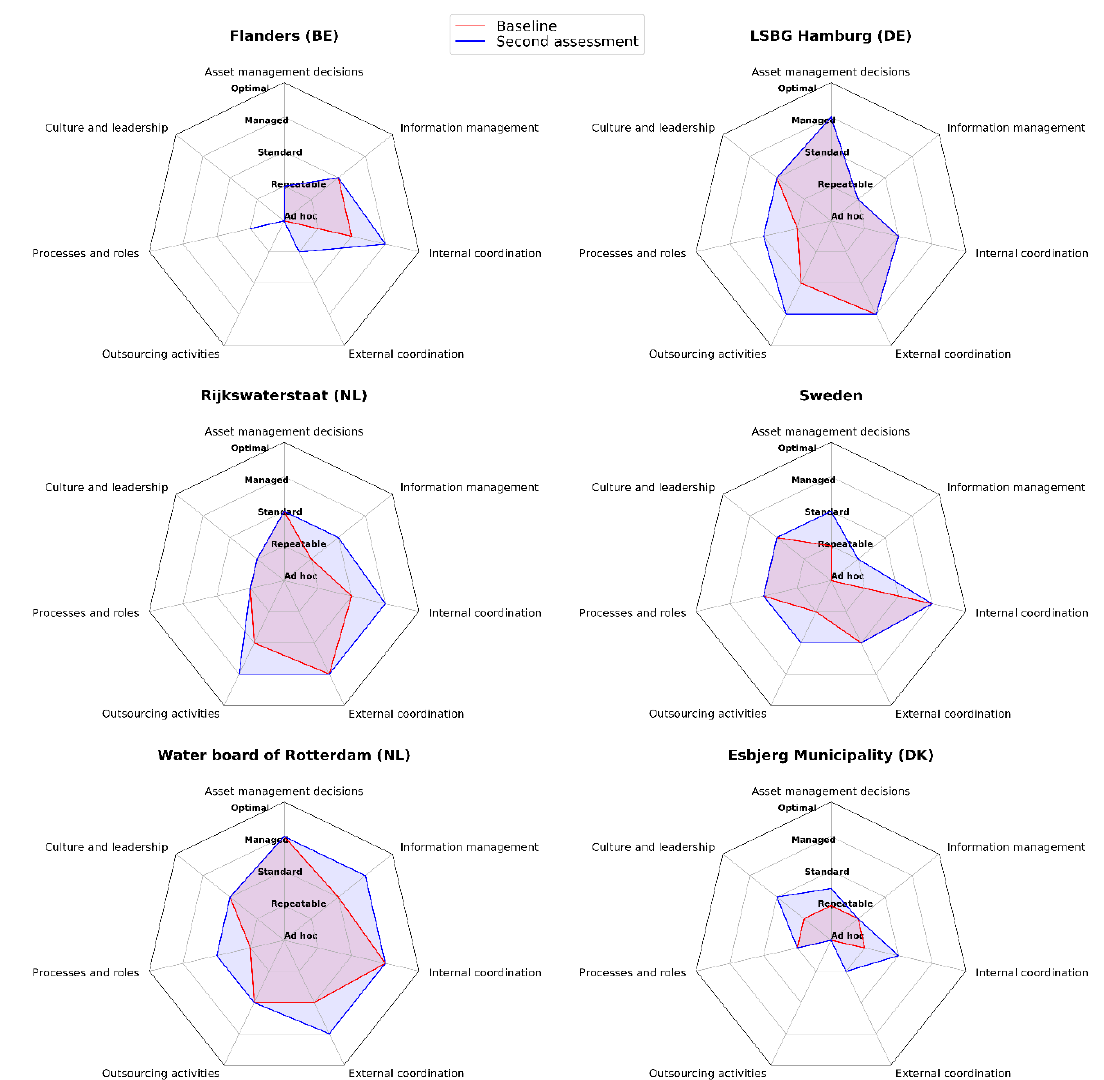
Figure 2. Results of the self-assessment of maturity across seven organizational dimensions during the FAIR